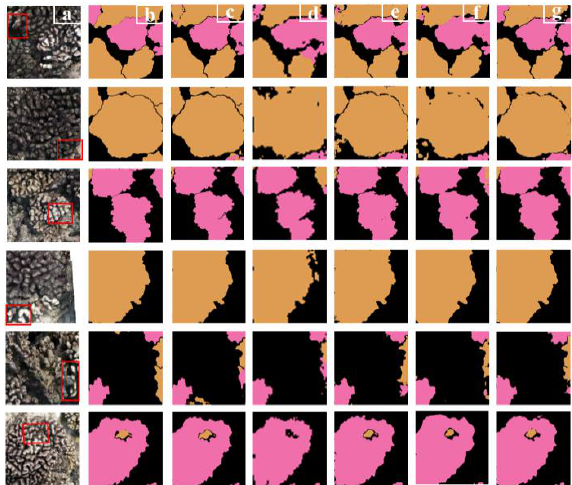
Figure 8 . Comparison of the five CNNs results on the test set.